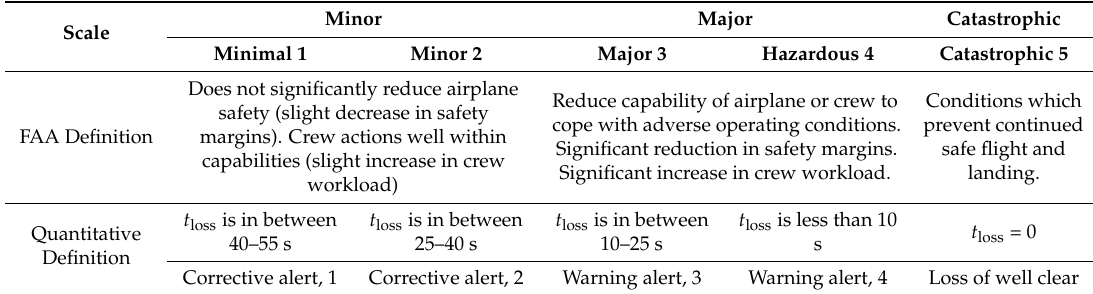
Table 9. Severity